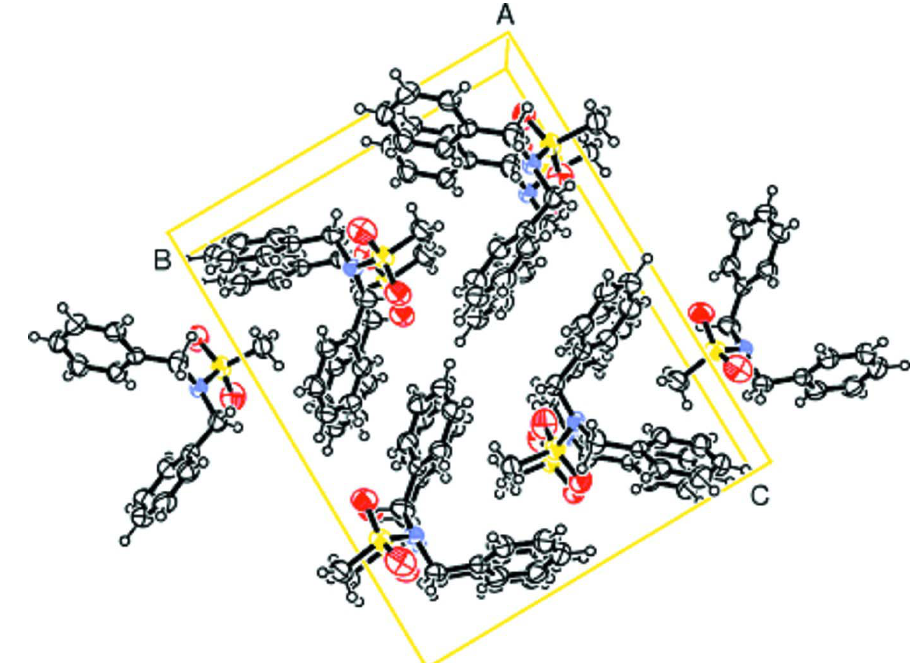
Figure 2 The packing of (I), viewed down the a